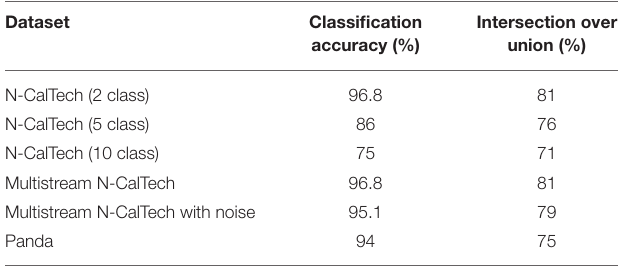
TABLE 1 | Results from each of the experimental setup, listing both the accuracy and intersection over union.